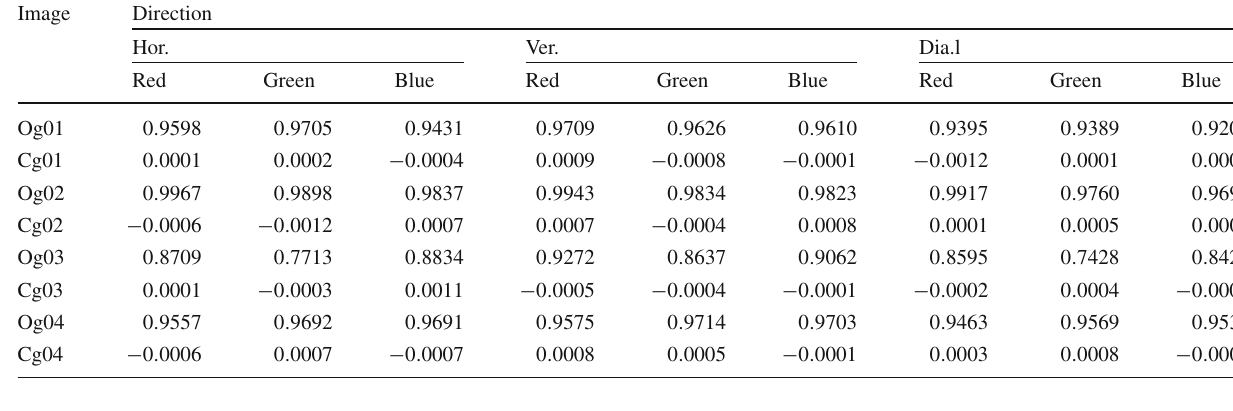
Fig. 3 Investigated dataset, in which the original images are given in the top row, while the bottom row indicates the corresponding cipher images using the proposed image cryptosystem Table 2 Outcomes of correlation coefficients for the investigated dataset